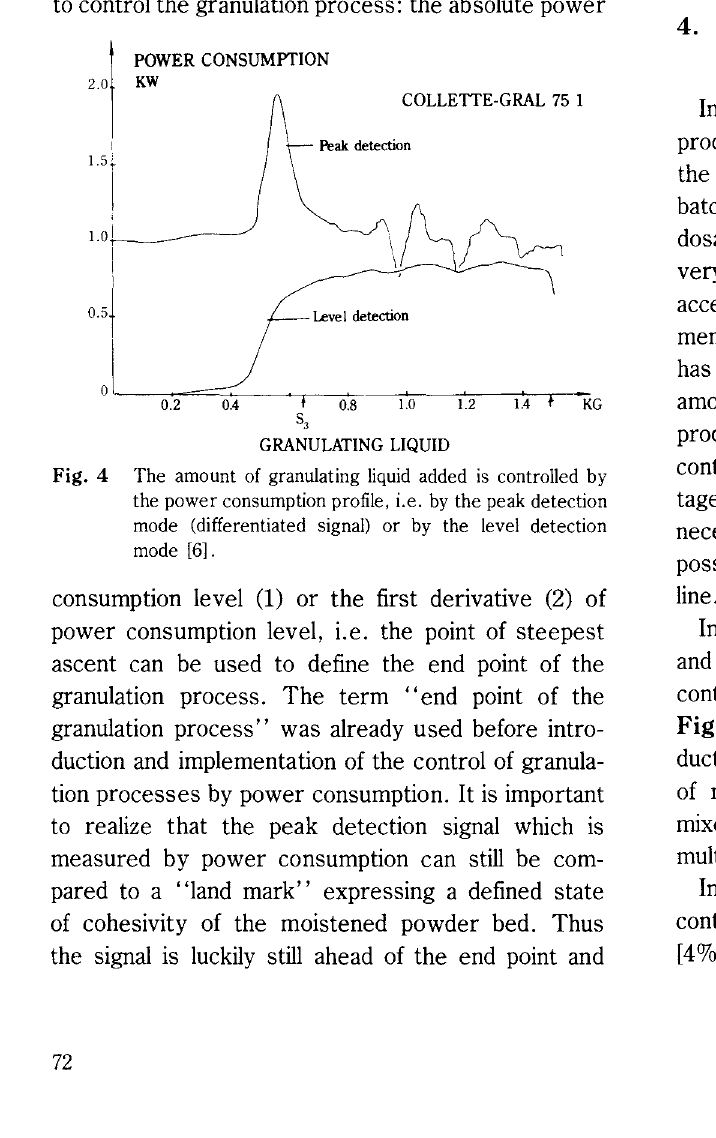
Fig. 3 Typical power consumption profile for the agglomeration of lactose 200 mesh (DMV monohydrate) with 4o/o (W /W) polyvinyl-pyrrolidone of binder. The solution is added at a constant rate. 1r Corresponds to the dimensionless amount of granulation liquid added, i.e. to the ratio of interparticulate void space filled up with liquid [12].